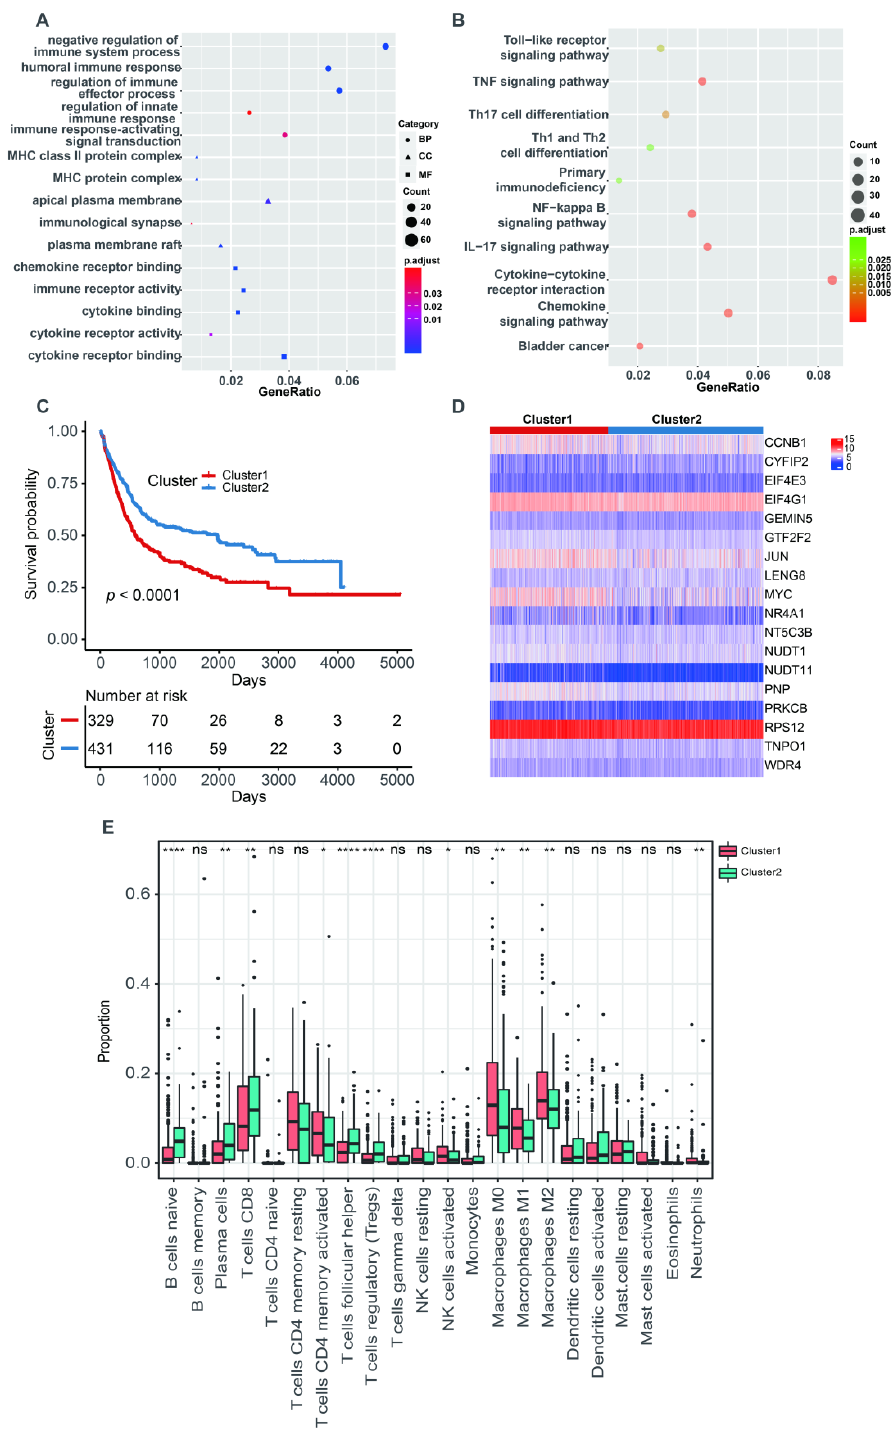
Figure 3. The characteristics of two m7G-related clusters. ( A ) The GO analysis of 1108 DEGs. ( B ) The KEGG analysis of 1108 DEGs. ( C ) The Kaplan – Meier survival analysis of OS between two m7G-related clusters. ( D ) The heatmap for different distribution of 18 m7G-related genes between two m7G-related clusters. ( E ) The abundance of 22 tumor-infiltrating immune cells between two m7G-related clusters. Data in ( E ) were analyzed by Wilcoxon test; ns, no significance; * p < 0.05, ** p < 0.01, *** p < 0.001 and **** p < 0.0001.